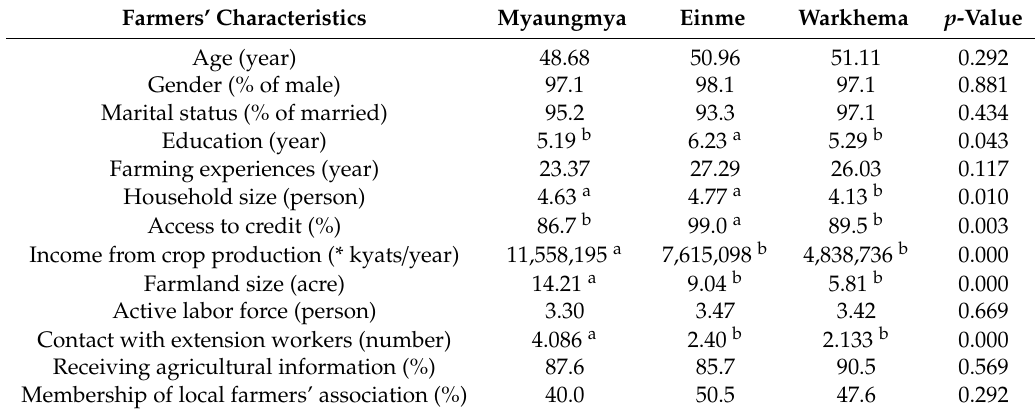
Table 10. Comparison of farmers’ characteristics among three